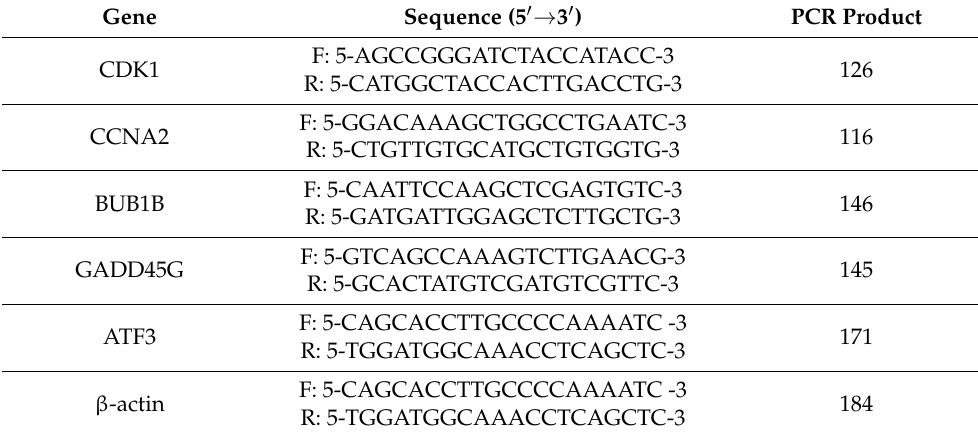
Table 1. Details of primers used in real-time PCR. F: forward; R: reverse.